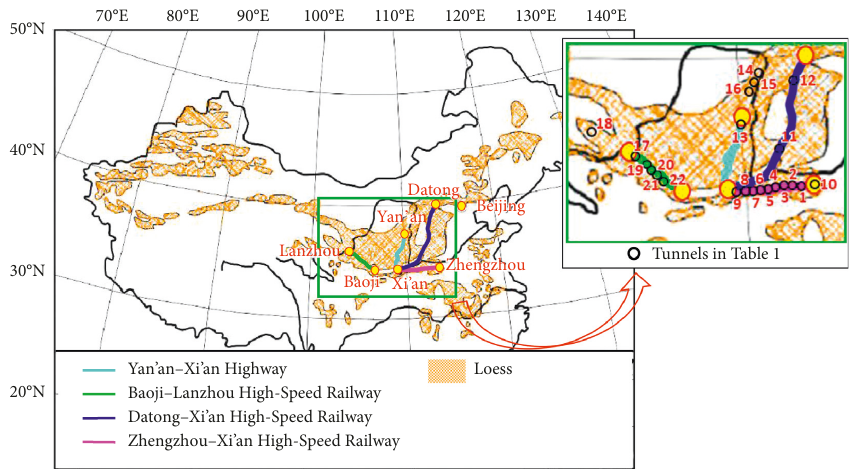
Figure 1: Outline of major loess deposits in China [1].